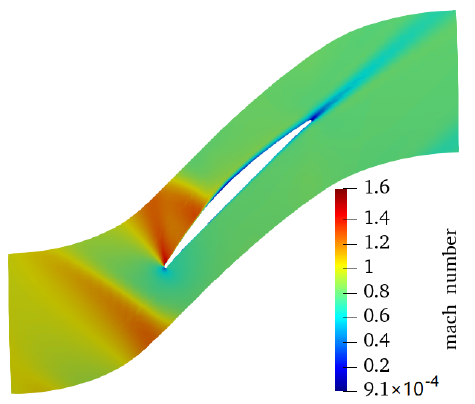
Figure 4. The mesh used in this study.